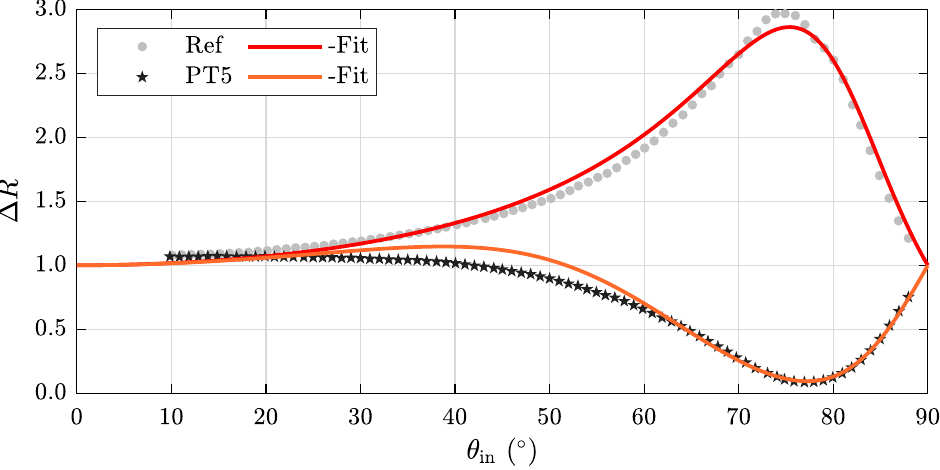
Figure 9. Experimental data sets for specimen Ref and PT5 together with a corresponding fit function described in Equations (1) and (5), respectively. We exclude data points ranging to 60 ◦ for the fitting procedure due to the fact that the mentioned equations are valid only for high angles of